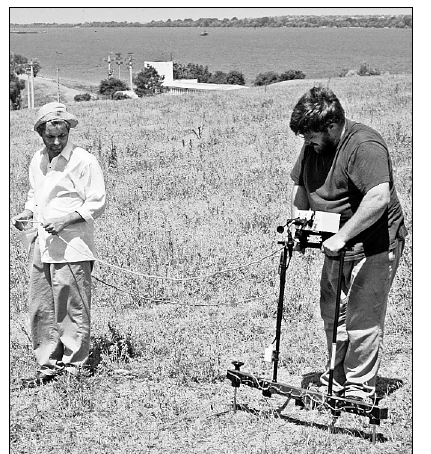
Figure 6 Plan of the site of Noviodunum published in 1973, 8 showing (labelled I , II , III ) what he believed to be three lines of ditches and banks defending the civil settlement.